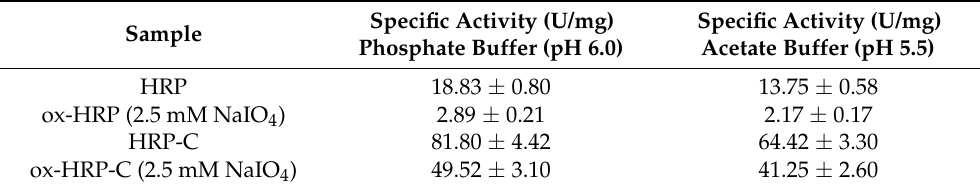
Table 1. Specific activities (U/mg) of commercial HRP, its oxidized form, purified HRP-C, and oxidized HRP-C in phosphate and acetate buffers.